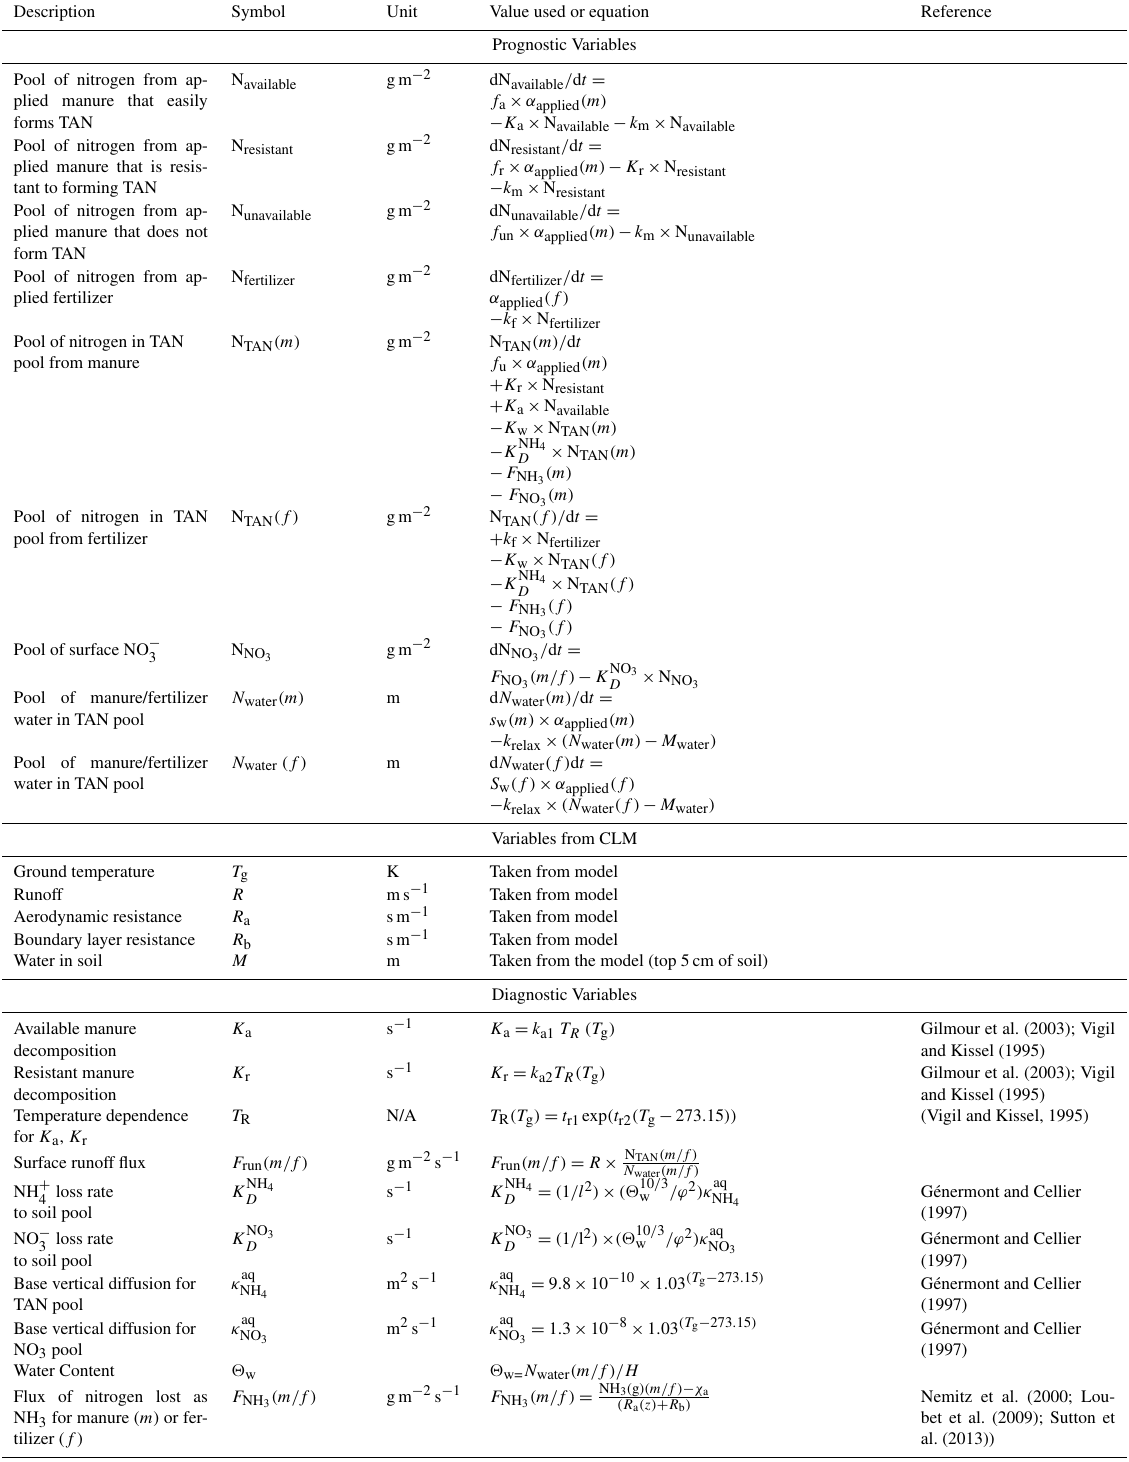
Table A1. Description of model variables and